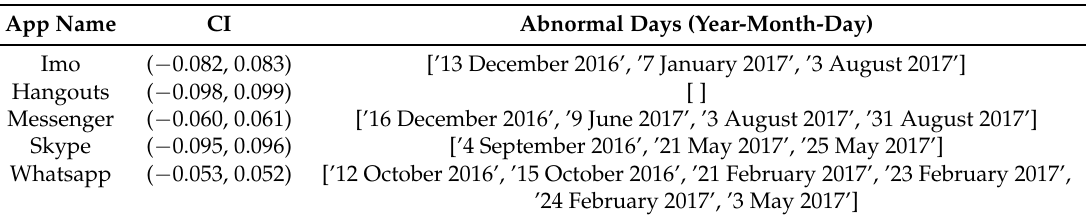
Table 3. Confidential intervals and identified abnormal